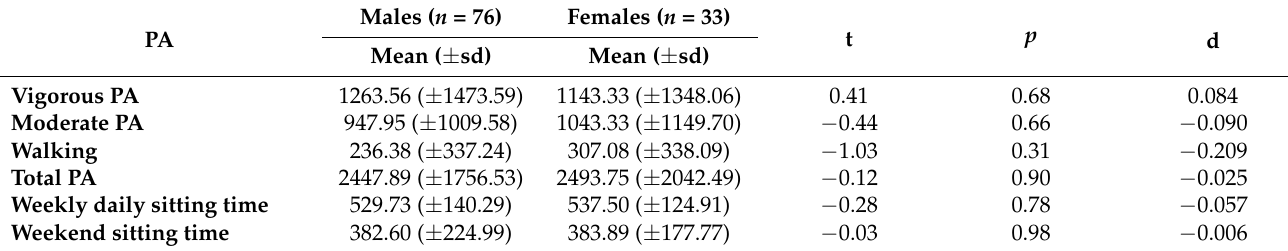
Table 3. Mean, standard deviation, and physical activity (PA) comparisons between sex.